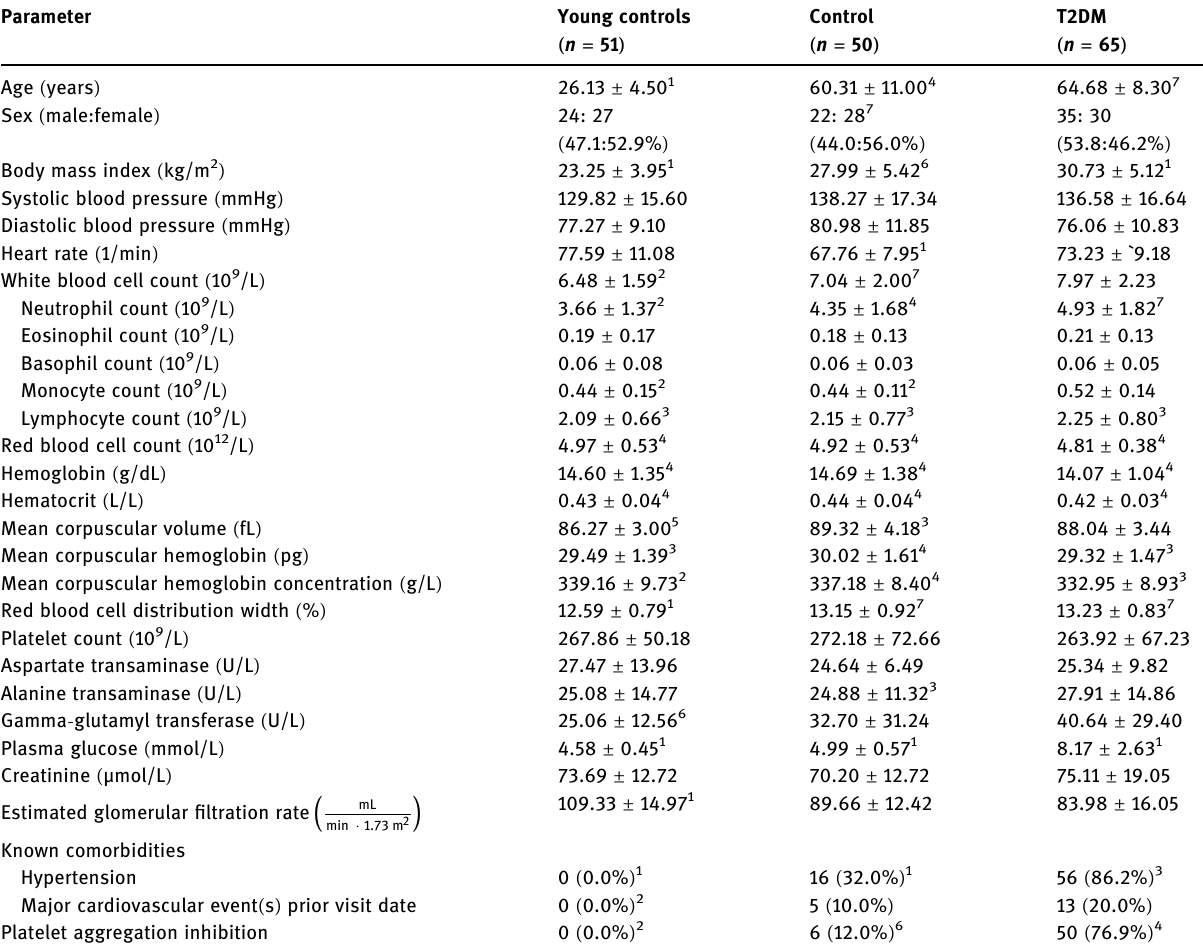
Table 2: Metabolic, clinical, and other parameters of voluntary control subjects Parameter Young